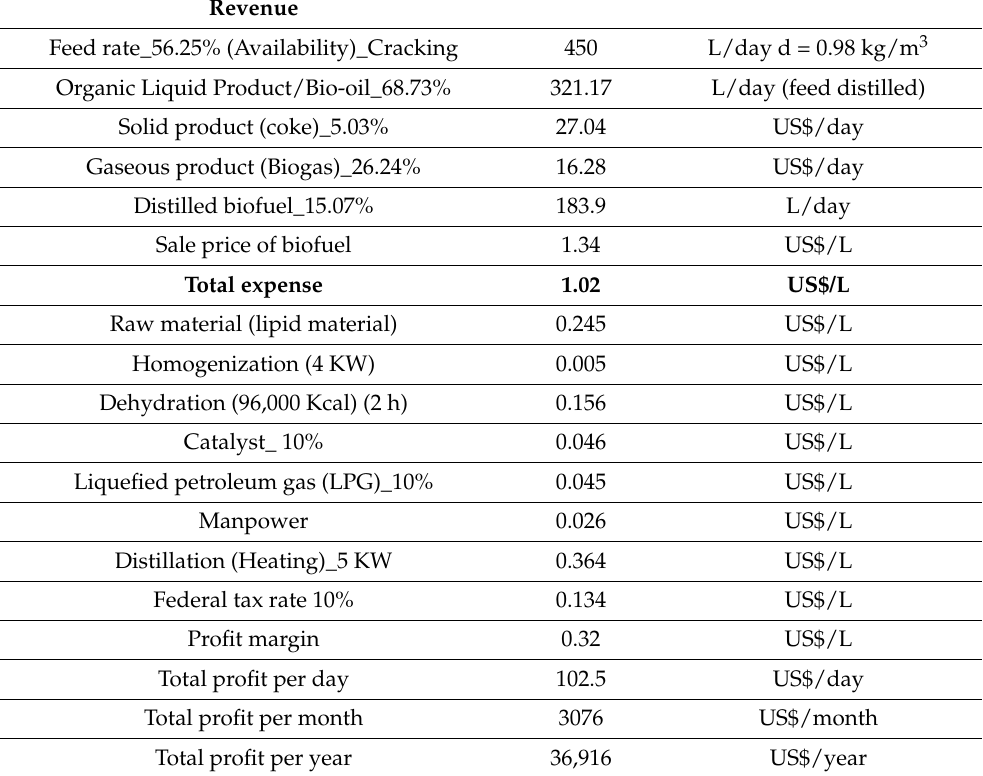
Table 3. Revenues and expenses of using lipid-based material as